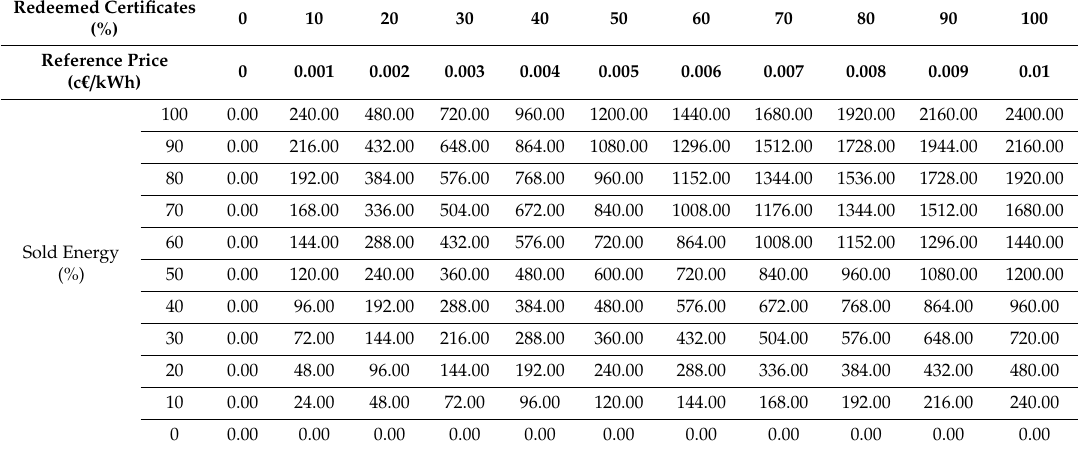
Table 3. Extra revenue obtained by selling Guarantees of Origin certificates (in € ). Redeemed Certificates